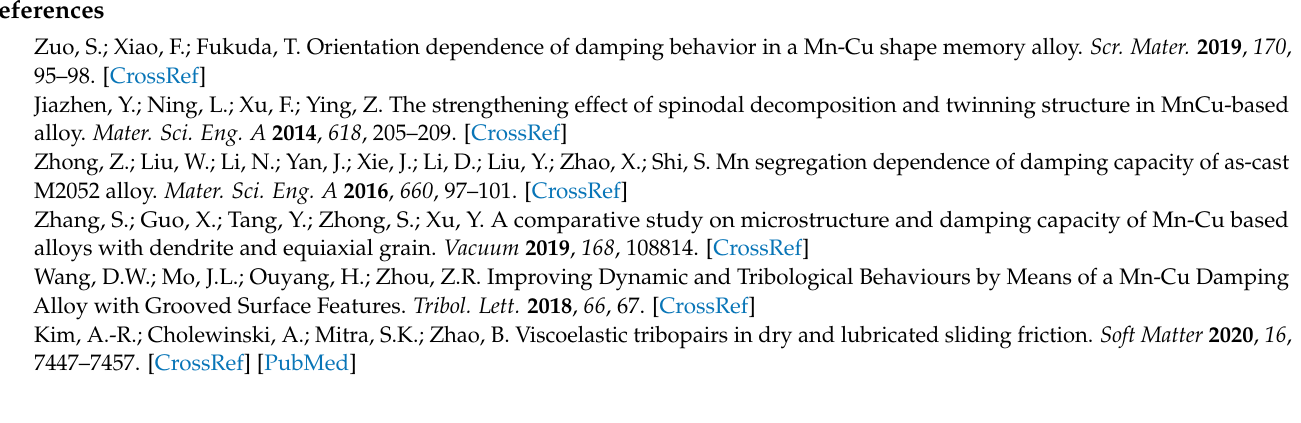
different weaving parameters. Figure S2: Friction coefficients of samples with different weaving width. Figure S3: Friction process simulation of Mn-Cu and Fe-Zn with different weave center distance. Figure S4: Friction process simulation of Mn-Cu and Fe-Zn with different sample thickness. Figure S5: Friction process simulation of Mn-Cu and Fe-Zn with different weave